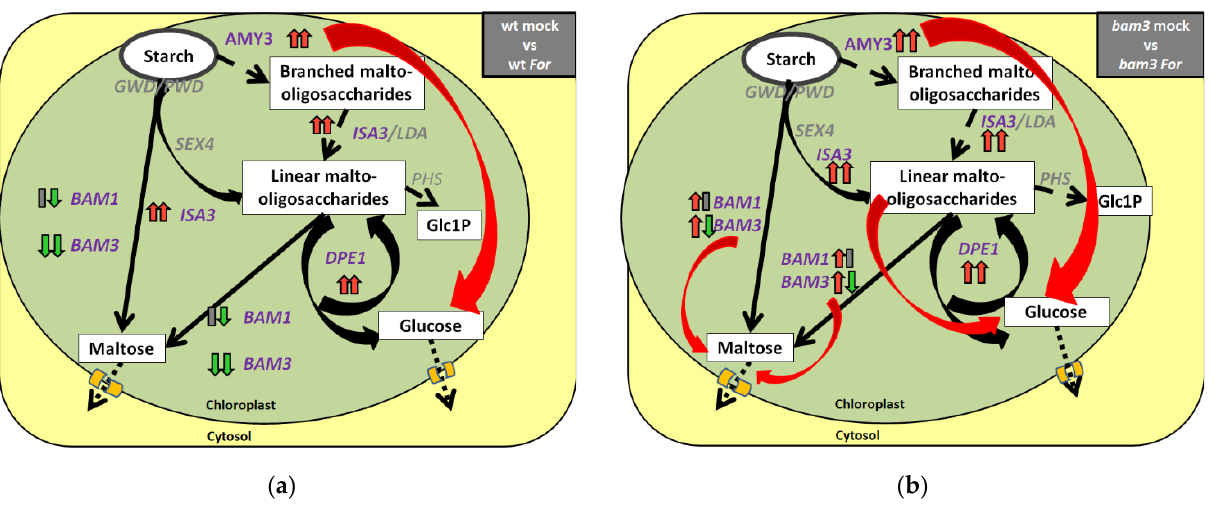
Figure 10. Transcriptional regulation of starch degradation in chloroplasts of Arabidopsis thaliana ( a ) wt plants and ( b ) bam3 mutants 3 days (left arrow) and 7 days (right arrow) post inoculation (dpi) with Fusarium oxysporum f. sp. raphani ( For ). Genes studied are written in purple, while red and green arrows indicate up- and downregulated genes, respectively, while grey rectangles indicate no significant differentiation. Estimated fluxes are indicated by relative arrow size. Dashed arrows represent the minor steps in Arabidopsis. Initially, glucan water dikinase (GWD) and phosphoglucan water dikinase (PWD) disrupt the packing of amylopectin double helices by phosphorylation, while α -amylases (AMY3) seems to help degradation as a minor step, releasing branched maltooligosaccharides. Then, β -amylases (BAM1 and BAM3) and the debranching enzyme (DBE) isoamylase 3 (ISA3) release maltose and maltooligosaccharides (black arrows). Phosphoglucan phosphatases, such as SEX4 and the DBE (ISA3), complete the degradation. Short maltooligosaccharides are also metabolized by the glucanotransferase disproportionating enzyme (DPE1) producing glucose and a spectrum of linear oligosaccharides, the larger of which are again substrates for the other degradative enzymes. Maltooligosaccharides are metabolized in the stroma, while maltose and glucose are exported to the cytosol. In the present study, transcriptional regulation of BAM1 , BAM3 , ISA3 , AMY3 , and DPE1 leads towards more glucose production in A. thaliana bam3 plants compared to wt, especially after inoculation with For (b, big red arrows).